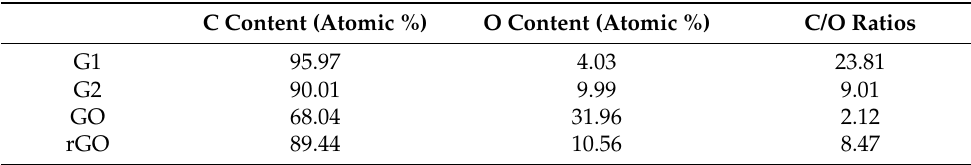
Table 1. XPS compositions of prepared GN and GO. C Content (Atomic